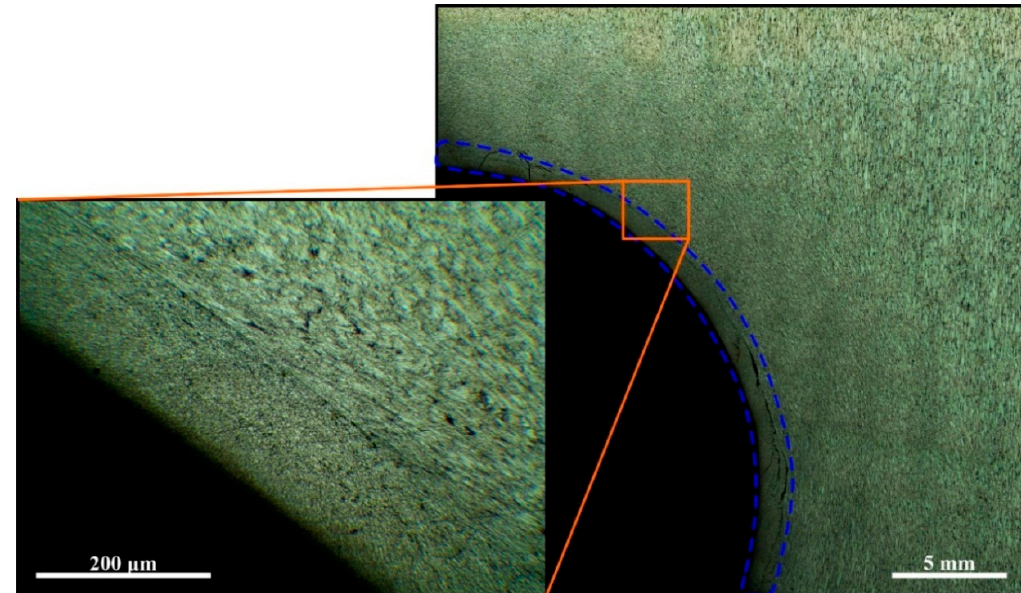
Figure 13. Optical images of the microstructures formed in the FSW tool exit hole metal leading edge metal (Section 2.2 in Figure 2). Blue dotted line contour denotes the transfer layer area. Completely recrystallized metal is observed in a thin 0.5–0.6 mm layer, which was stuck to the FSW tool and thereby transferred in a spiral bottom-to-surface trajectory.